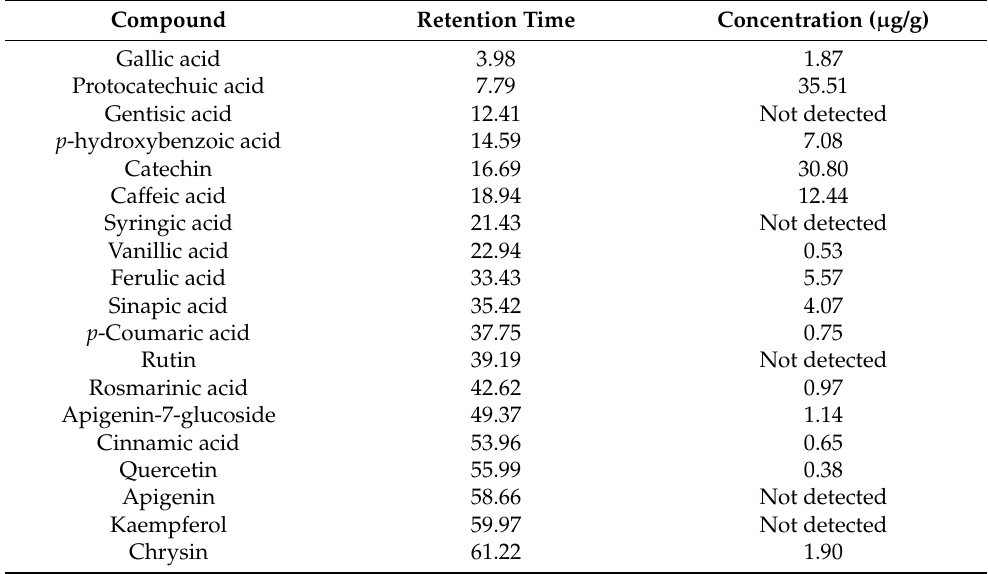
Table 3. Effect of AvS treatment on liver damage parameters in CsA-induced hepatotoxicity in rats. Parameters